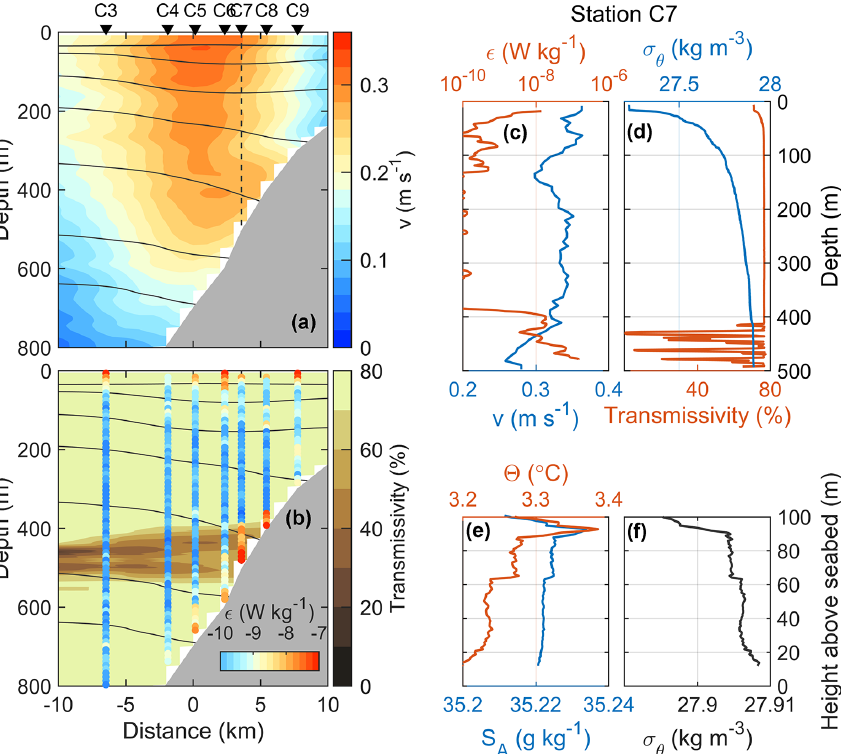
Figure 9. Distribution of (a) the velocity component into the section and (b) light transmissivity, together with selected isopycnals (black). Dissipation rate (log 10 (cid:15) ) is color coded in vertical columns in (b) . Profiles collected at station C7: full depth profiles of (c) dissipation rate and velocity and (d) σ θ and transmissivity and the bottom 100m profiles of (e) (cid:50) and S A and (f) σ θ